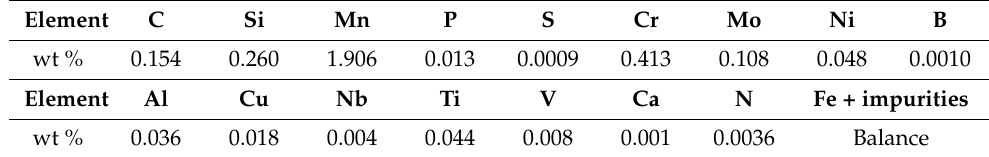
Table 1. Composition (wt %) of the investigated steel.